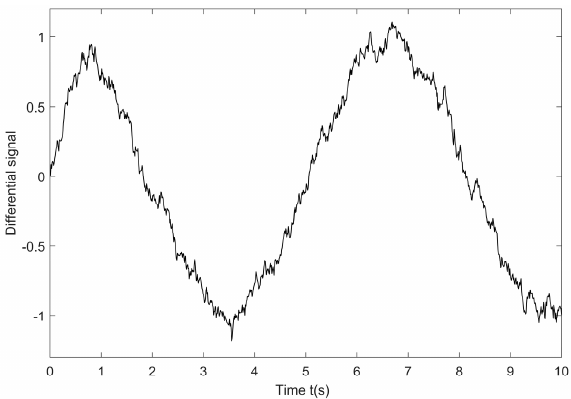
Figure 3. Approximate differential signal output.